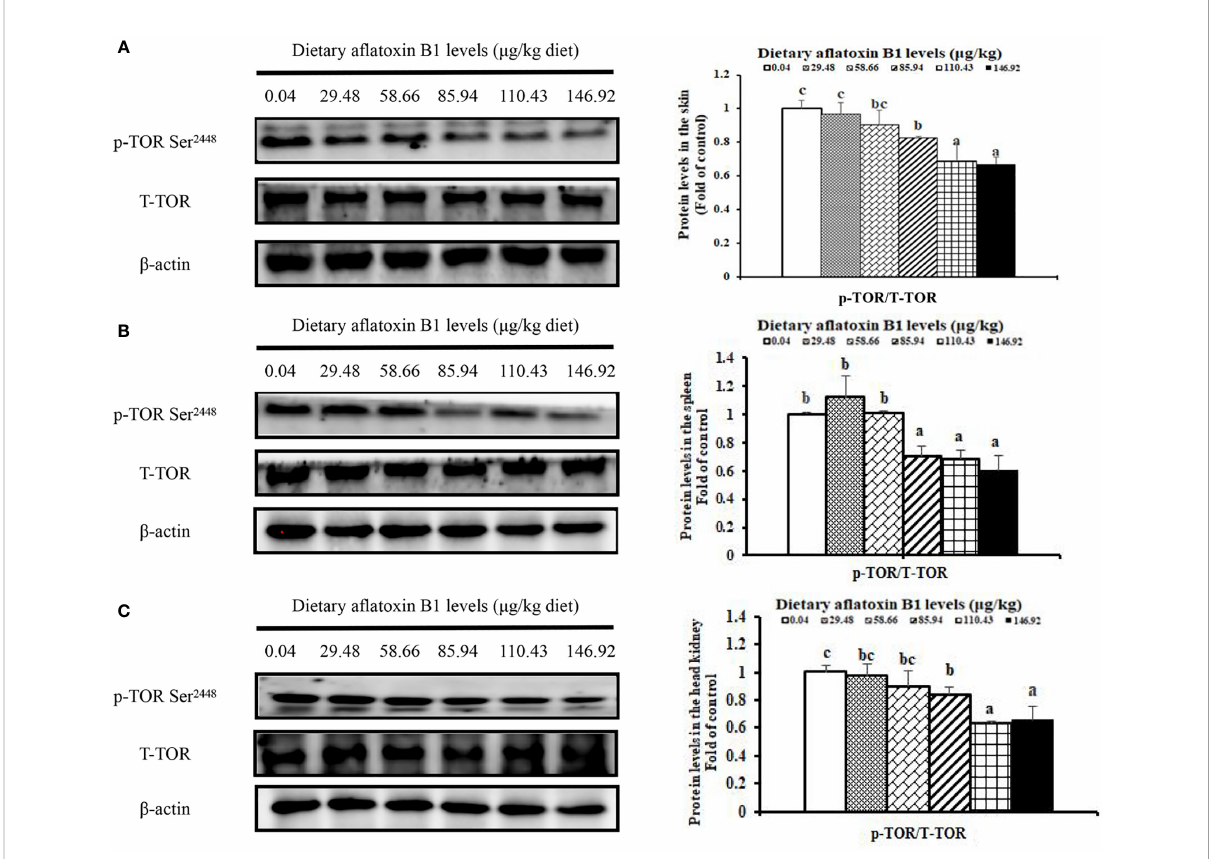
FIGURE 6 The protein levels phosphorylation of TOR at Ser2448 in the skin (A) , spleen (B) and head kidney (C) of grass carp after infection of A hydrophila . n=6 (six fi sh in each group). Different letters indicate signi fi cant differences (P <